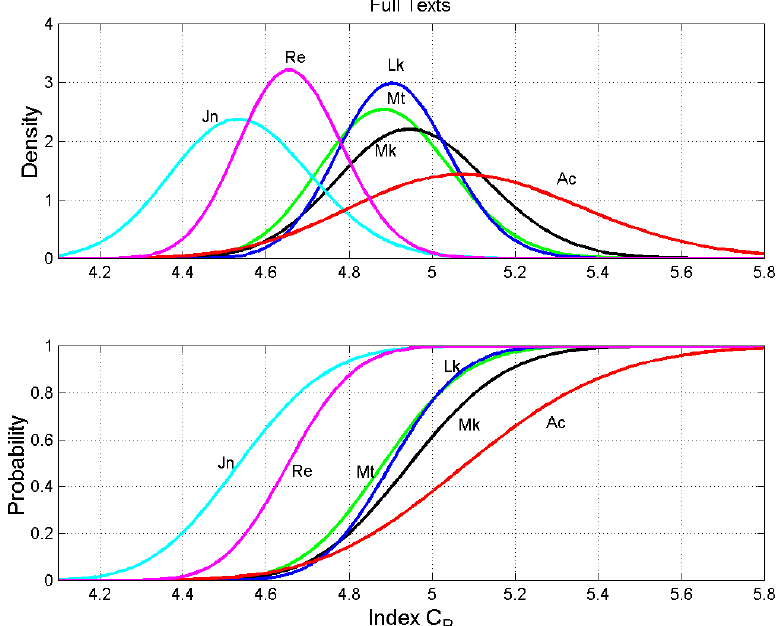
Figure 2. Probability density functions (upper panel) and probability distribution functions (lower panel) of the number of words per sentence 𝐶 𝑃 . Matthew : green line; Mark: black line; Luke : blue line; John : cyan line; Acts : red line; Revelation : magenta line.